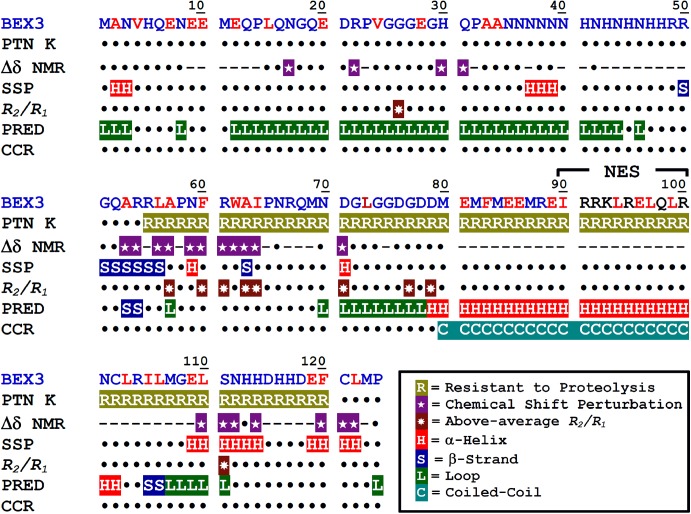
Amino acid sequence of BEX3 highlighting its structural elements.PTN K: amino acid segments resistant to proteinase K. The residues that were predicted to be recognizable by proteinase K by the Peptide Cutter program (http://web.expasy.org/peptide_cutter) are indicated in red. Δδ NMR: represent residues with significant chemical shift perturbation by urea. Dashes represent values that were not determined. SSP: Residues with > 10% secondary structure propensity calculated from Cα, Cβ and Hα chemical shifts. R
2
/R
1: NMR relaxation indicating residues with below-average conformational flexibility. PRED: Secondary structure prediction from amino acid sequence. CCR: Coiled-coil prediction from amino acid sequence.